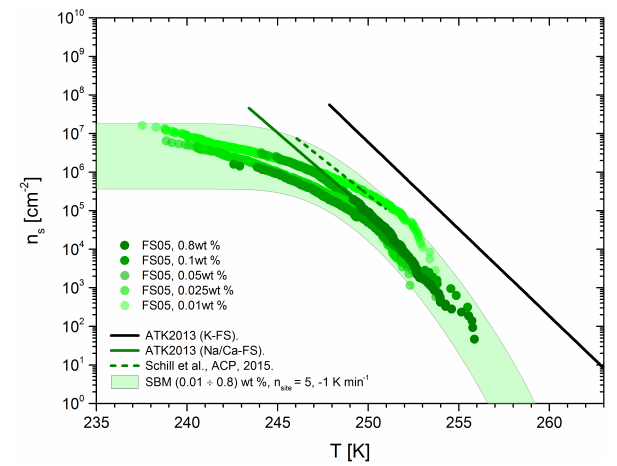
Figure 10. n s (T ) curves of Na/Ca-feldspar suspensions FS05. Shaded area shows the range of n s (T ) values predicted by Eq. (4) with fixed-fit parameter set µ θ = 1 . 33 rad, σ θ = 0 . 102 rad, n site = 5, and concentration of feldspar suspensions varied between 0.01 and 0.8wt%. Black and green solid lines are exponential fits of data from ATK2013 for K-rich and Na/Ca-rich feldspar suspension droplets, respectively.